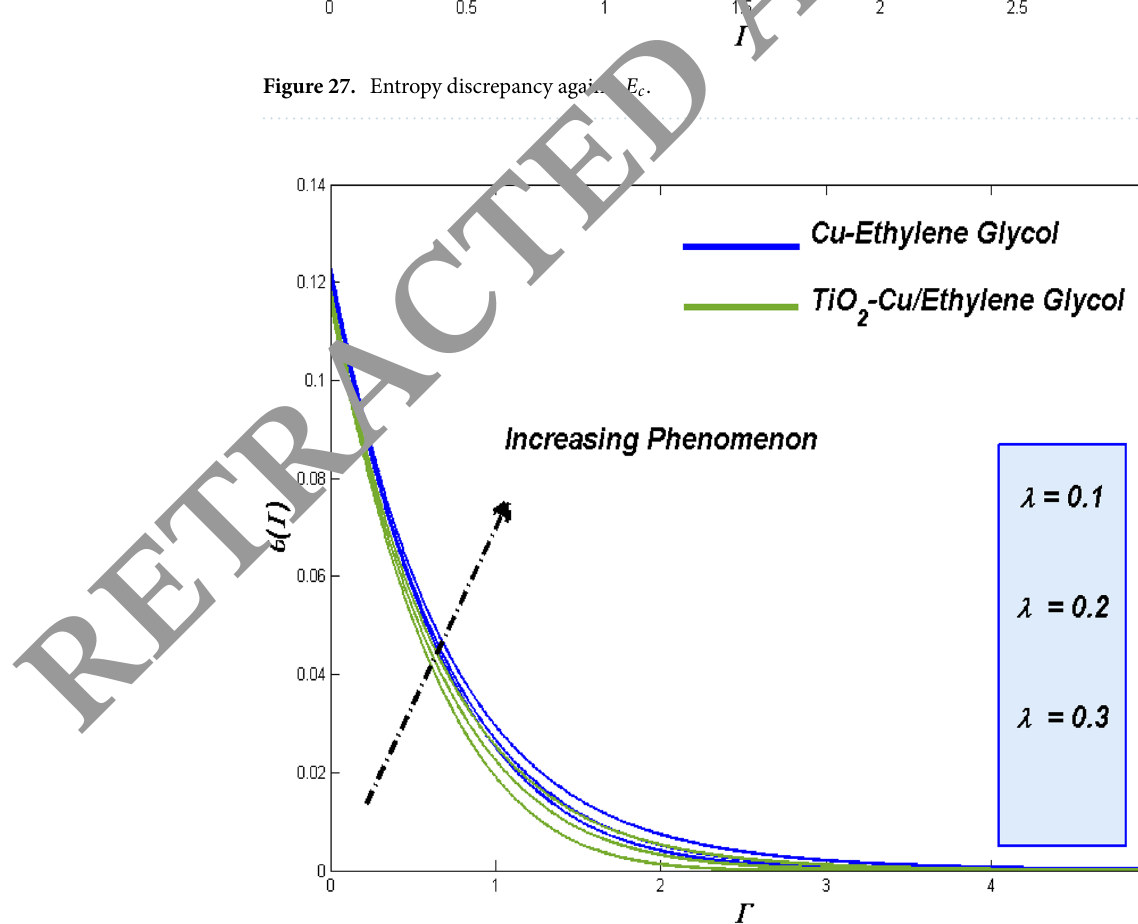
Figure 27. Entropy discrepancy against E c .